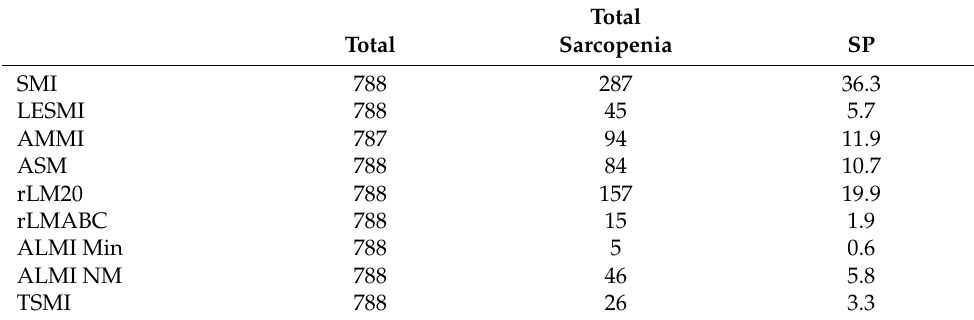
Table 3. Prevalence of sarcopenia by DXA-derived